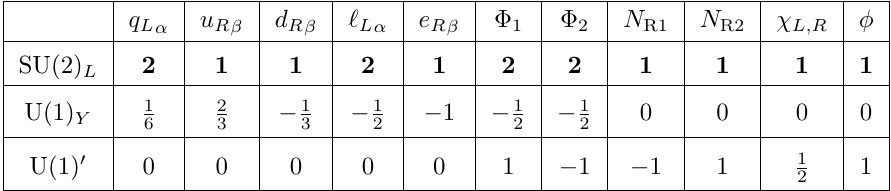
Table 1 . Irreducible representations of the fields of the model under the electroweak SU(2) L × U(1) Y × U(1) 0 gauge symmetry. The fields q Lα , ‘ Lα are left-handed SM doublets while u Rβ , d Rβ , e Rβ are right-handed SM singlets where α, β label the three families of quarks and leptons. The fields N R1 , 2 are the two right-handed